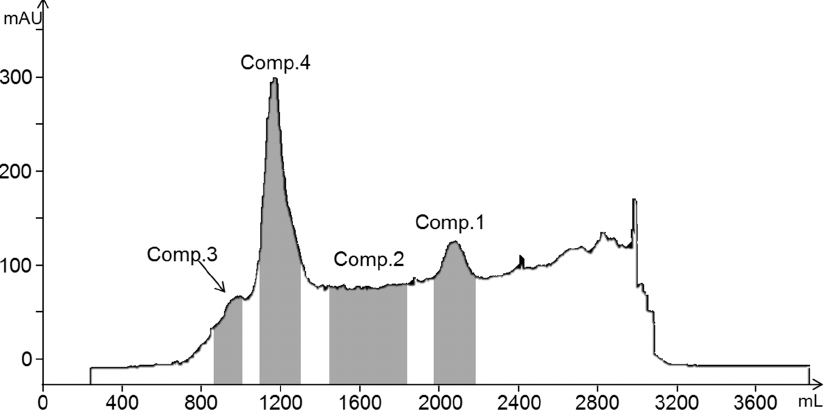
Figure 2. HSCCC chromatogram of the ethyl acetate fraction of the evening primrose seeds 50% ( v / v ) methanol extract (EME). Table 2. Partition coe ffi cient values ( K ) of chemical constituents from the ethyl acetate fraction of